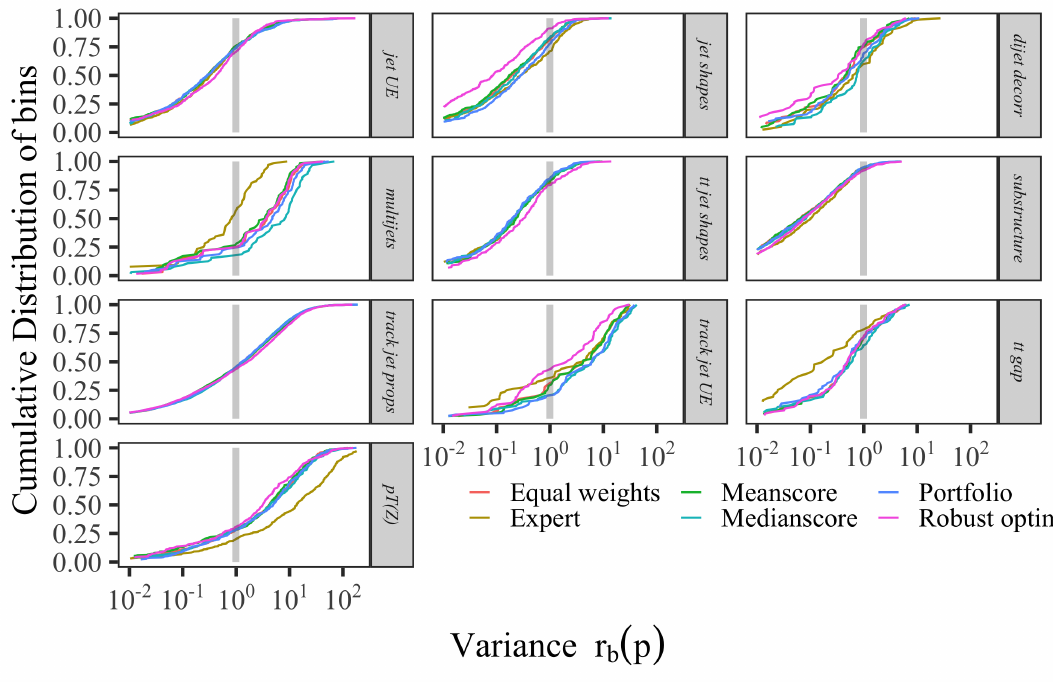
Figure 3: Cumulative distribution of bins (y-axis) in each category of the A14 dataset at different bands of variance levels (x-axis) given by r